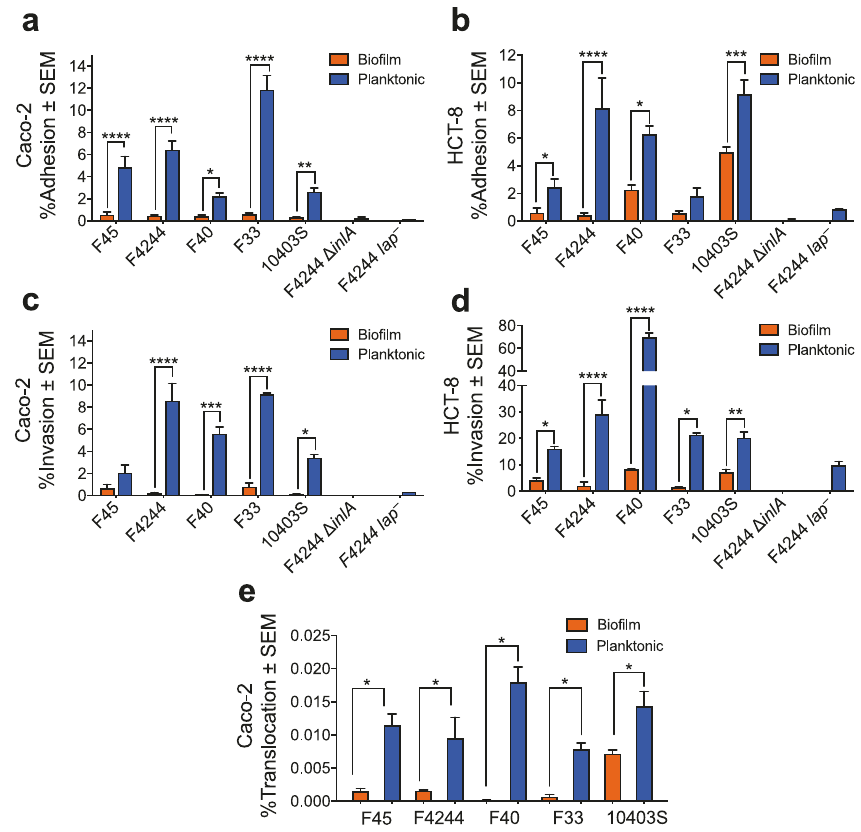
Fig. 2 Adhesion, invasion, and translocation characteristics of bio fi lm-forming sessile and planktonic cells on the cultured cell line. Comparison of adhesion ( a, b ) and invasion ( c, d ) in Caco-2 and HCT-8 cells and transepithelial translocation across Caco-2 cells ( e ) between L. monocytogenes bio fi lm-isolated sessile and planktonic cells on Caco-2 and HCT-8 cells. The percentage was calculated by dividing the amounts of adhered, invaded, or translocated bacteria by the amounts of bacteria in the inoculum. Data are the average of at least three independent experiments performed in triplicate. All error bars represent SEM. Pairwise Student ’ s t -test was used for statistical analysis. **** P < 0.0001; *** P < 0.0005; ** P < 0.005; * P <